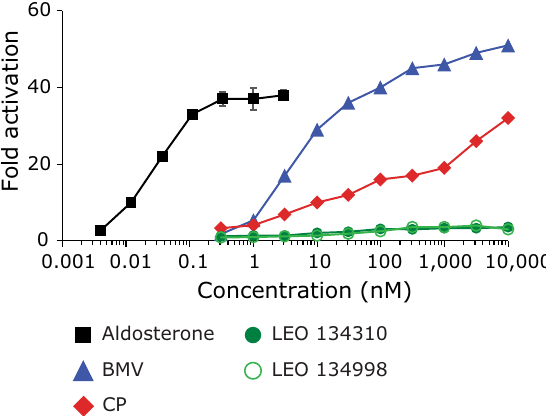
Figure 1. LEO 134310 does not induce mineralocorticoid receptor (MR) signalling. Dose–response curves for induction of luciferase activity in MR-luciferase reporter cells by aldosterone, CP, BMV, LEO 134310, and LEO 134998 after incubation for 24 h.